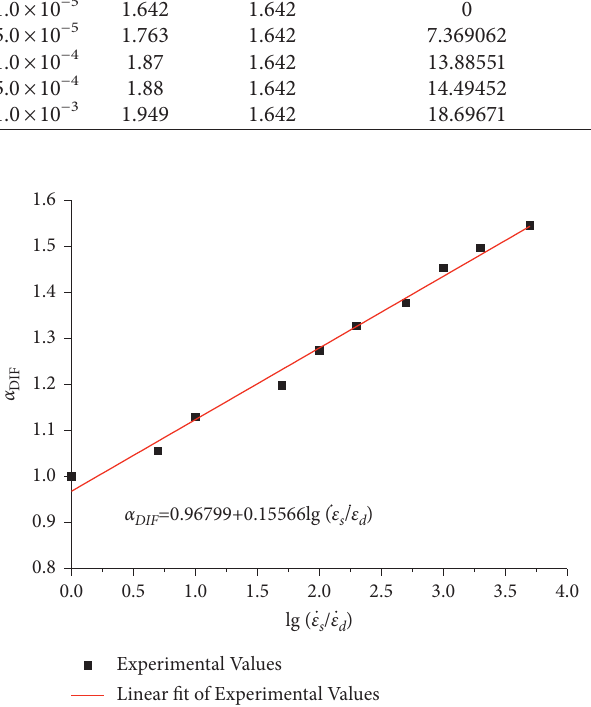
Figure 4: Increase coefficient of peak stress of light aggregate concrete under different strain rates.